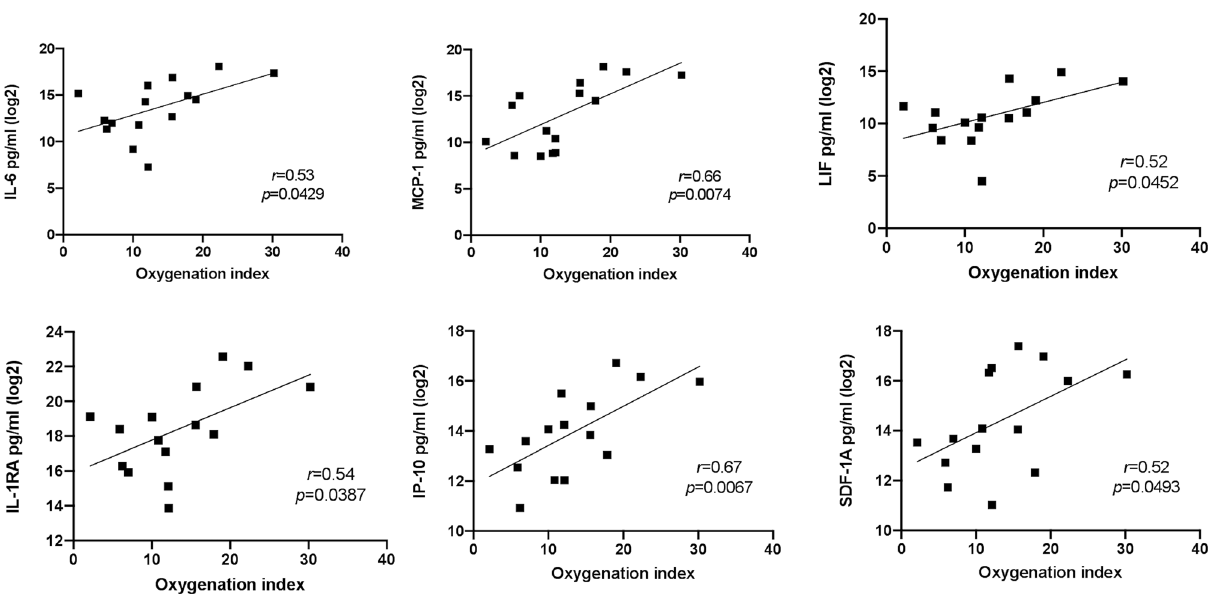
Figure 3. Correlation plots between early timepoint respiratory cytokines and the oxygenation index. r = Pearson’s correlation